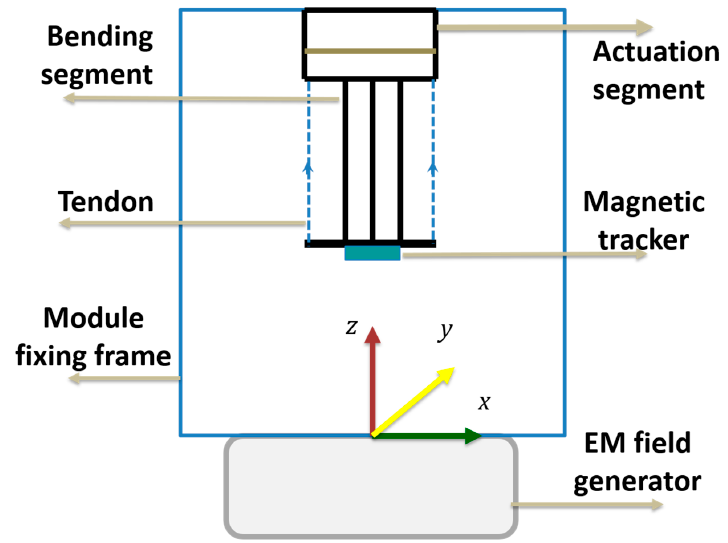
Figure 9. Aurora system. Setup to measure the position and orientation of the module. EM: Electromagnetic.